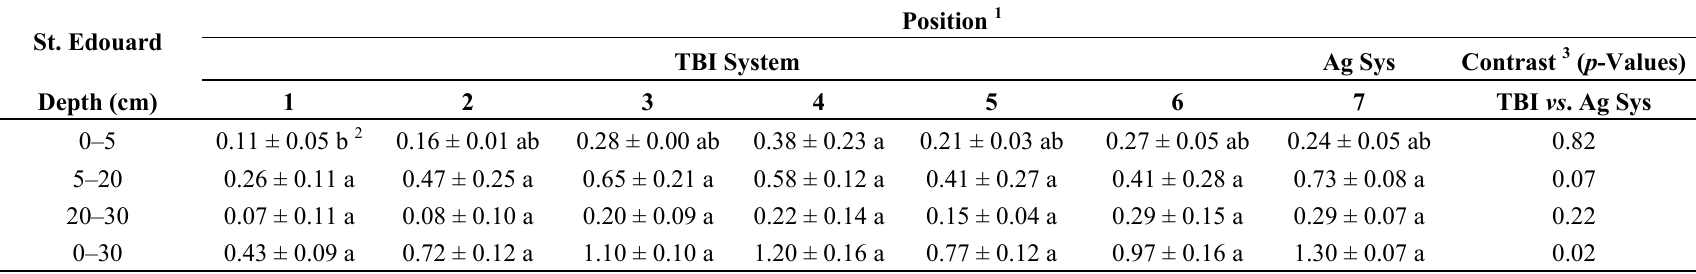
Table 3. Average soil N stocks (kg N m − 2 ± standard deviation, n = 3) for a tree-based intercropping (TBI) system and an adjacent agricultural system (Ag Sys) at St. Edouard, southern Quebec,